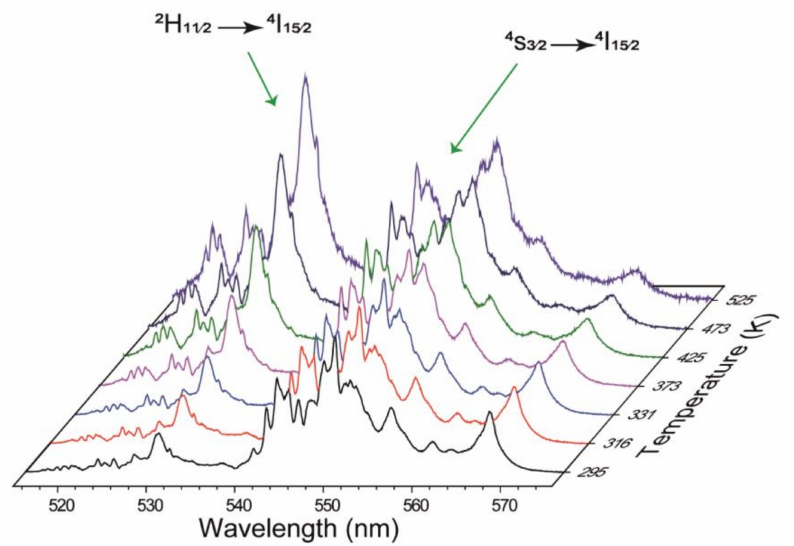
Figure 3. Thermal evolution of the normalized green upconverted emissions of La 2.9 Er 0.1 NbO 7 phosphor from 295 K up to 525 K under 975 nm laser